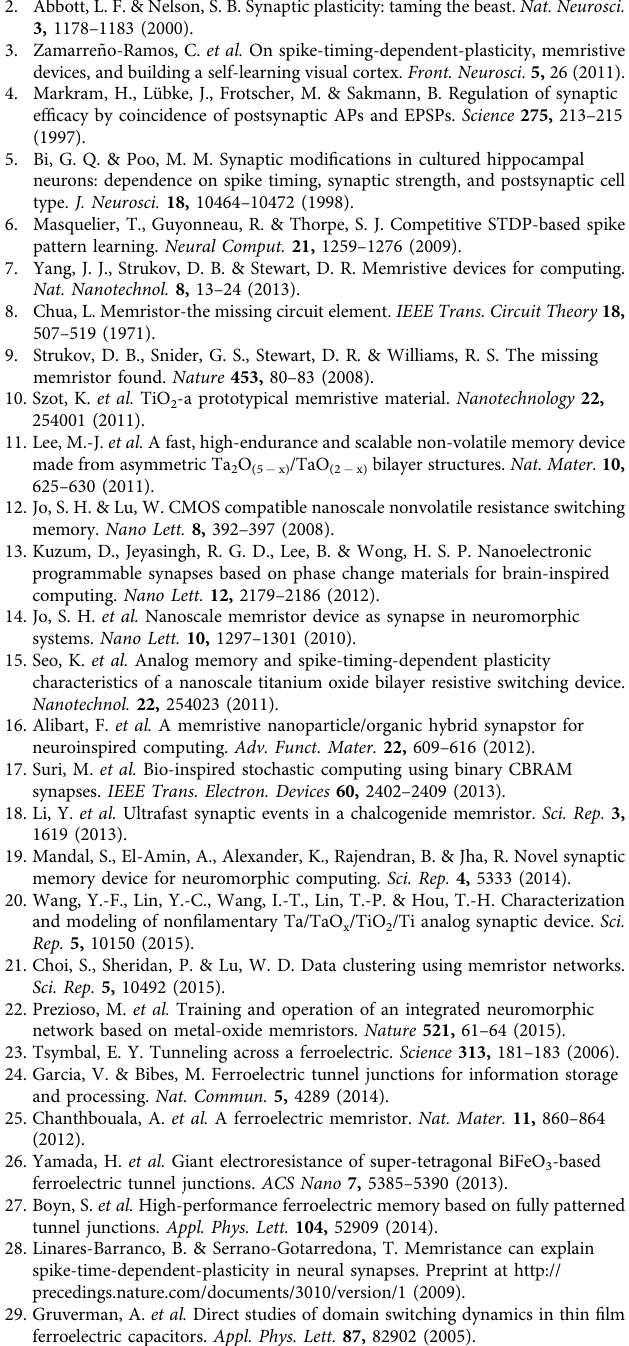
Fig. 3d: R init ( D t o 0) ¼ 6 (cid:3) 10 5 O , R init ( D t 4 0) ¼ 1.2 (cid:3) 10 7 O